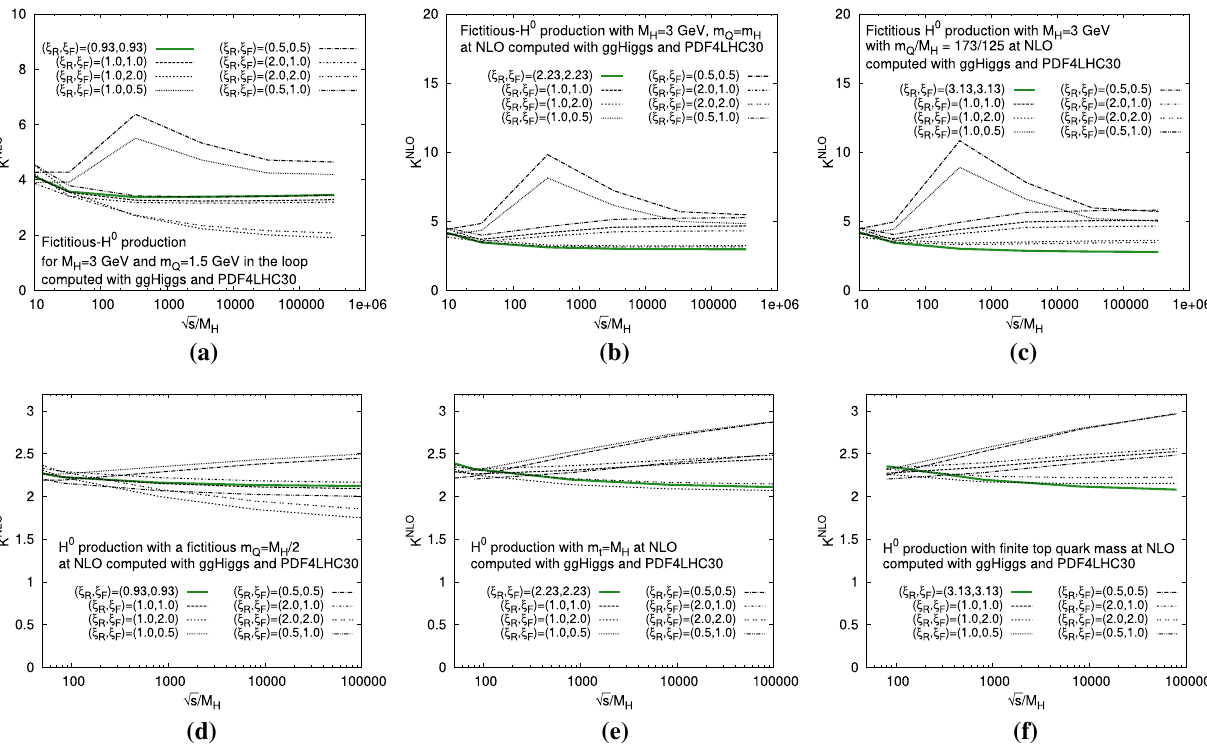
Fig. 4 K NLO for (top) fictitious ˜ H 0 and (bottom) H 0 with different (fictitious) heavy-quark masses for PDF4LHC15_nlo_30 as a function of √ s / M H for the usual 7-point scale choices and our ˆ μ F scale with μ R = μ F . [Only the case (f) is realistic, all the other are academical